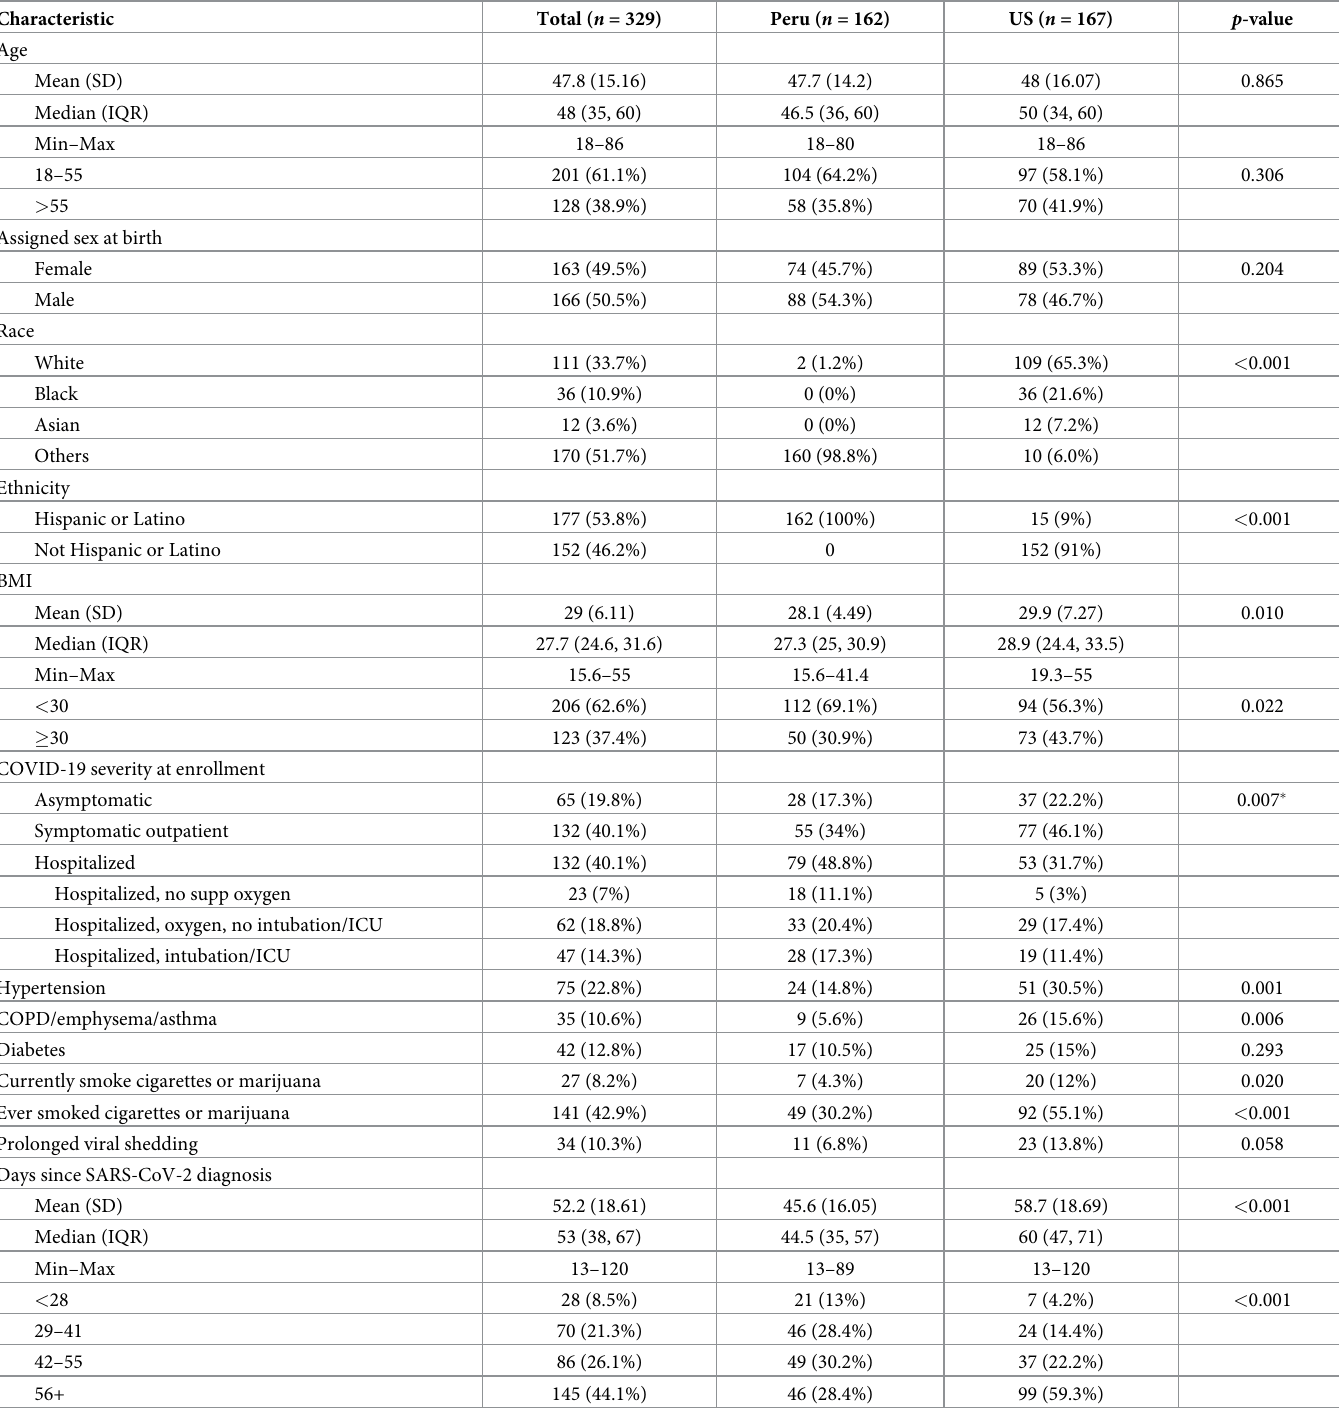
Table 1. Summary of participants characteristics at